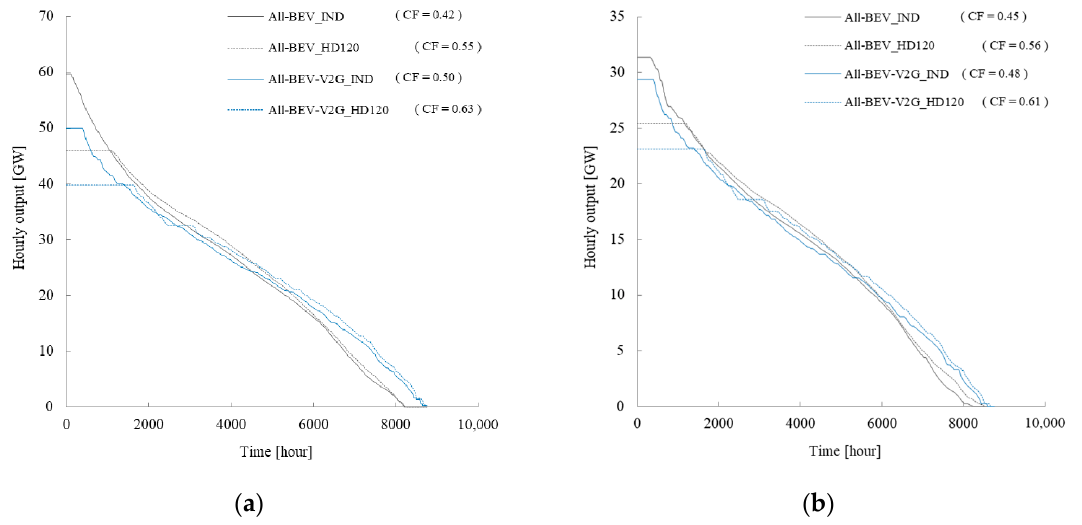
Figure 5. Duration curves in each scenario. ( a ) Electrolyzer. ( b ) Methane synthesizer.